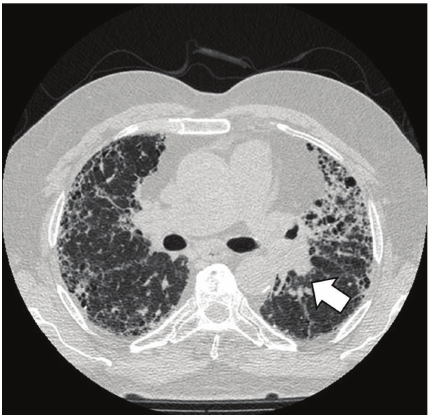
Figure 1: CT scan of a 69-years-old male with IPF and squamous cell carcinoma.